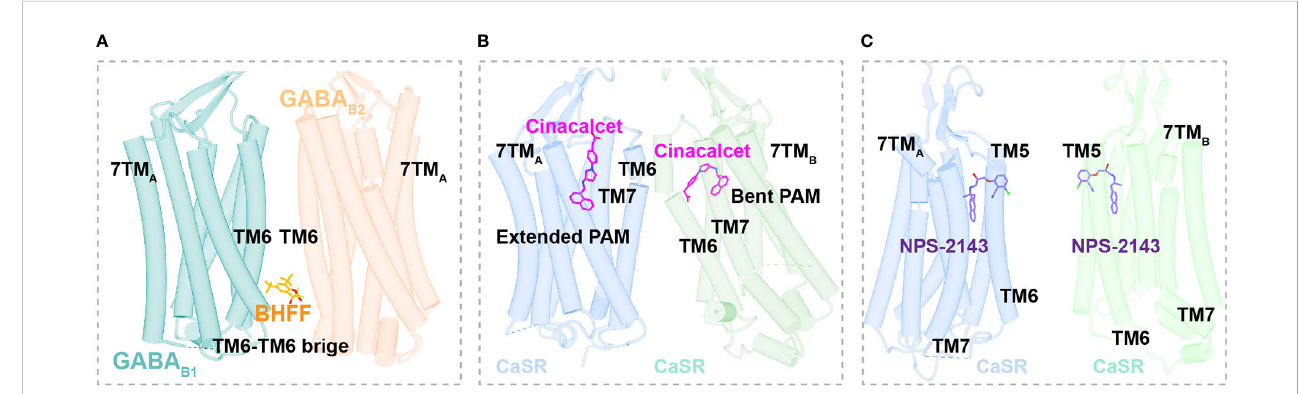
FIGURE 5 Binding Sites of allosteric modulators in Class C GPCRs. (A) Close view of binding sites of positive allosteric modulator BHFF (orange, sticks) in GABA B (dark cyan and light salmon, cartoon) (PDB ID: 7EB2). (B) Close view of binding sites of positive allosteric modulator cinacalcet (magentas, sticks) in CaSR (corn fl ower blue and medium aquamarine, cartoon) (PDB ID: 7M3F). (C) Close view of binding sites of negative allosteric modulator NPS-2143 (medium purple, sticks) in CaSR (corn fl ower blue and medium aquamarine, cartoon) (PDB ID: